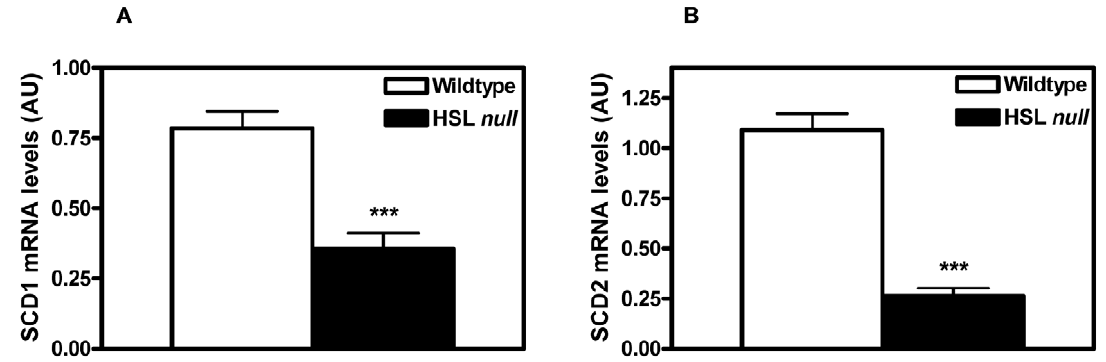
Figure 1. Decreased expression of 9-desaturases in white adipocytes from HSL null mice. Level of mRNA of SCD1 (A) and SCD2 (B) analyzed with real-time quantitative PCR in isolated adipocytes from periovarial WAT from 5 months old, HFD-fed wildtype and HSL null mice after an overnight fast (n=11). Values given are mean 6 SEM, ***p , 0.001, analyzed with Mann-Whitney U tests.